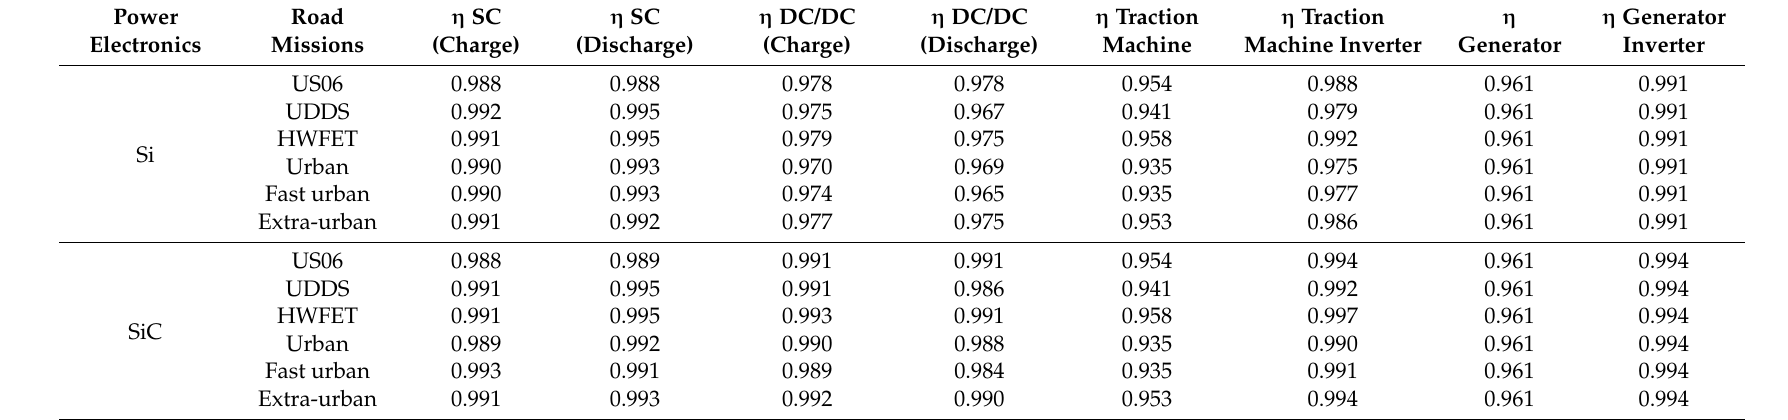
Table 6. Electric component average efficiencies on different road